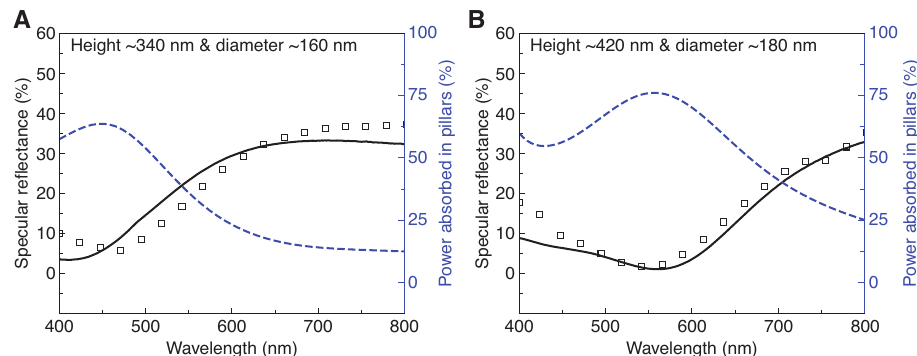
Figure 4: Relation between absorption spectral peak of an In/InP nanopillar and specular reflectance dip of DNPAs. The comparison between the specular spectral features (solid black lines are measured and square markers are simulated using supercell approximations) and power absorbed in the pillars (blue dashed lines obtained from periodic array simulations) for pillar diameters (A) ~ 160 nm and (B) ~ 180 nm. The results show that the specular spectral dips occur very close to the pillar absorption